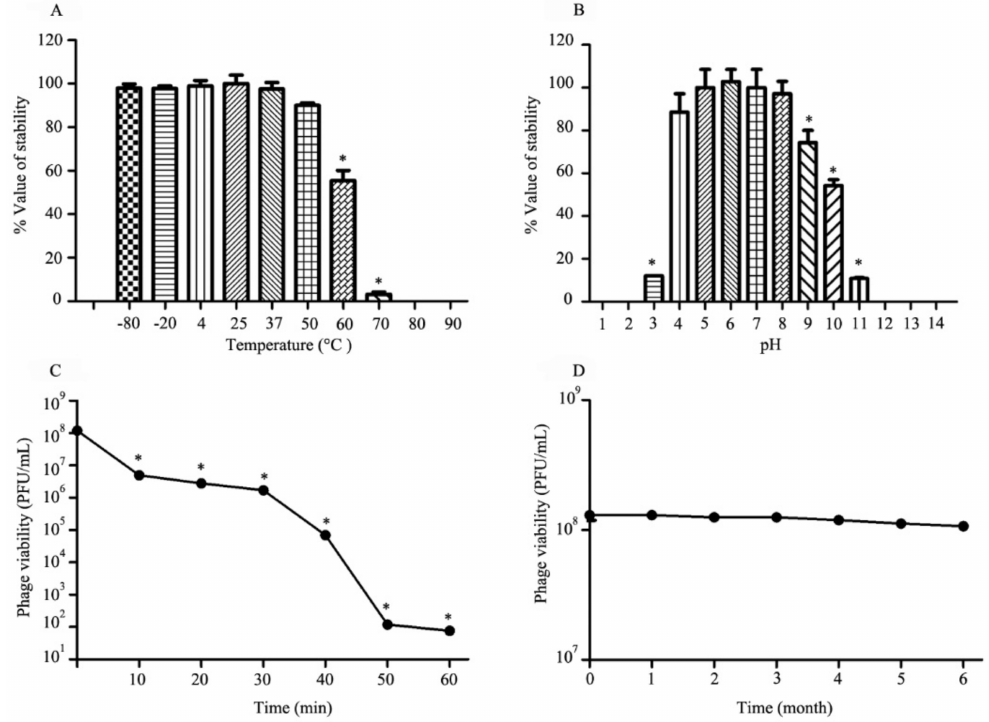
Figure 2. Stability of phage vABWU2101 under varied conditions. ( A ) Effect of temperature on the stability of phage vABWU2101. The phage was incubated at different temperatures for 2 h. ( B ) Effect of pH on the stability of phage vABWU2101. The phage was incubated for 2h under different pH values. ( C ) Effect of UV on the stability of phage vABWU2101. ( D ) Effect of long-term storage at 4 ◦ C on the stability of phage vABWU2101. Experiments were undertaken independently in duplicate with duplicate assay. The data show the mean ± SD (* p value <